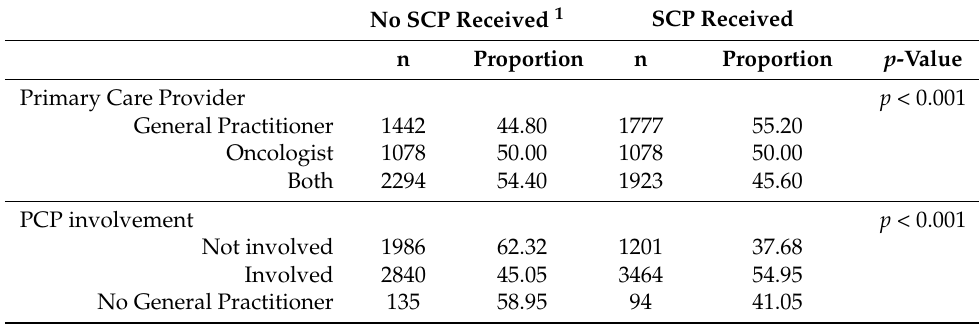
Table 2. Bivariate Analysis of SCPs and Patient Reported Satisfaction